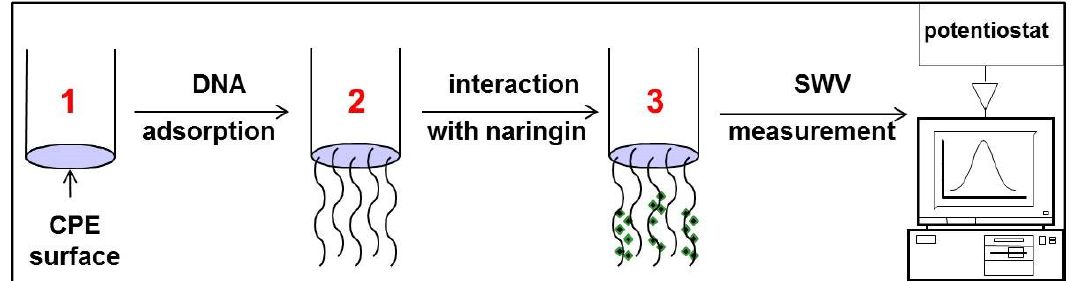
Figure A1. Graphic illustration of SWV methodology and measurement schemes. Figure A2. Average voltamperograms of different concentrations of naringin: (a) 0.5 μM; (b) 2.5 μM; (c) 5.0 μM; (d) 10.0 μM; (e) 20 μM. Figure A3. Average electrochemical signal of 5′GCTCGGTACGGAAGTTGAC oligonucleotide (a) and calf thymus DNA (b).